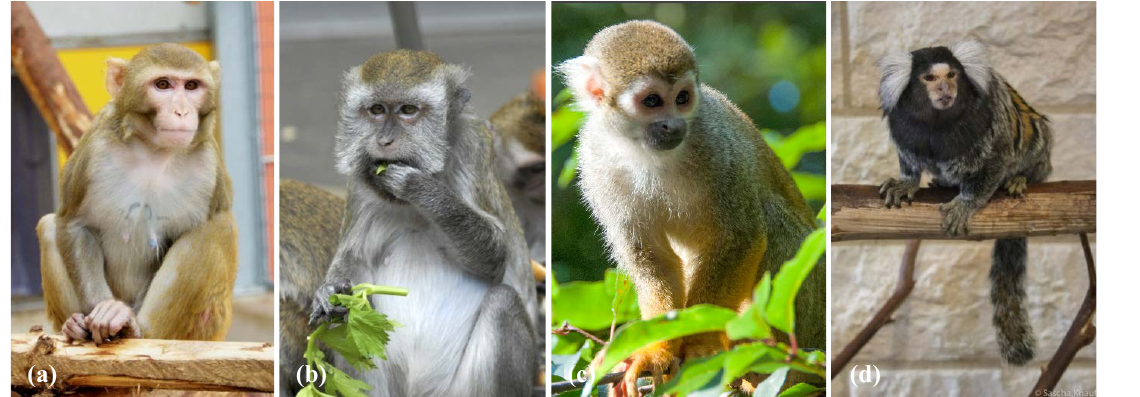
Figure 1. Nonhuman primates used in obstructive lung disease research. Rhesus macaques ( Macaca mulatta ) (a) and cynomolgus macaques ( Macaca fascicularis ) (b) belong to the family of old world monkeys (a, b) . Squirrel monkeys ( Saimiri sciureus ) (c) and marmoset monkeys ( Callithrix jacchus ) (d) are part of the new world monkey family. Source: (a, b, d) : German Primate Center GmbH (photographers: Margrit Hampe, JS Deutschland, and Sascha Knauf); (c) Serengeti Park Hodenhagen, Germany (photographer: Alexander